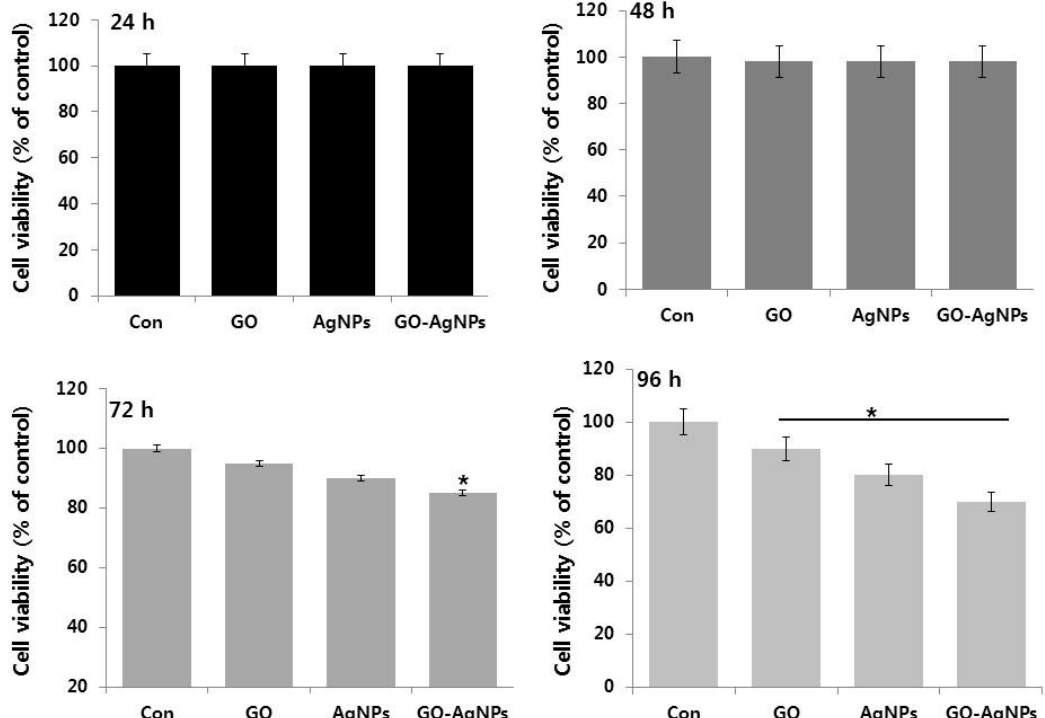
Figure 3. Time dependent effect on SH-SY5Y cells. The viability of SH-SY5Y cells was determined after 24-h exposure to GO (10 µg/mL), AgNPs (5 µg/mL) and GO-AgNPs (1.0 µg/mL) using the CCK-8 assay. At least three independent experiments were performed for each sample. The results are expressed as the mean ± standard deviation of three independent experiments The treated groups showed statistically significant differences from the control group by the Student’s t -test (* p < 0.05).